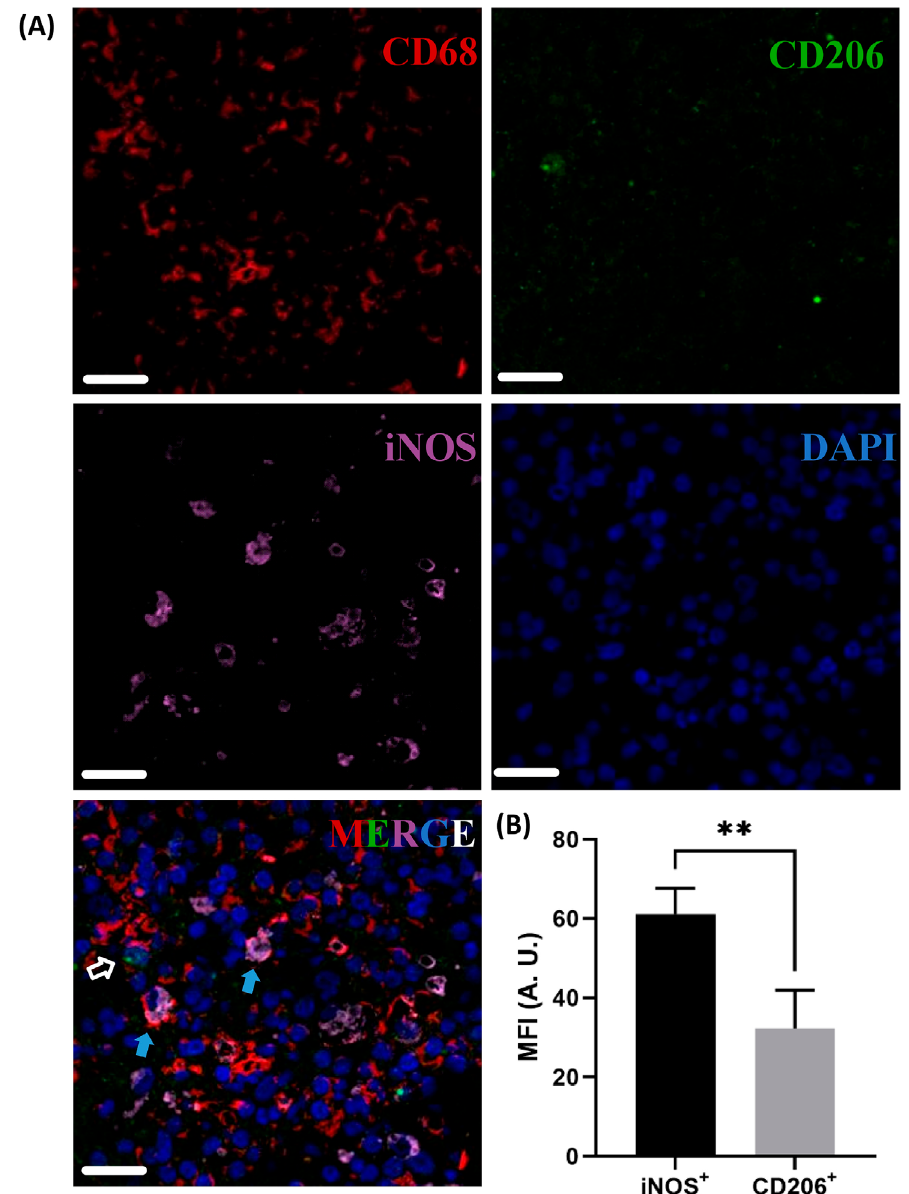
Figure 1- Polarized macrophage distributions in human apical periodontitis tissues. (A), representative TSA-based immunofluorescence staining images. (B), statistical results of the MFI analysis. CD68, general marker for macrophages; iNOS, specific marker for M1 macrophages; CD206, specific marker for M2 macrophages; DAPI, nuclear dye. In the merge picture, open white arrows indicate typical M2 macrophages (CD68+CD206+), blue arrows indicate typical M1 macrophages (CD68+iNOS+). MFI, mean fluorescence density; A.U., arbitrary unit. Scale bars, 20 μm.